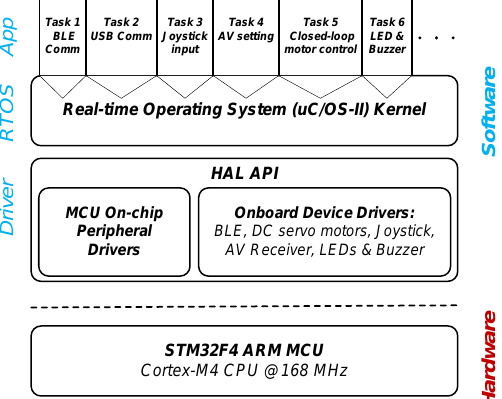
Figure 10. Real-time operating system based software framework.